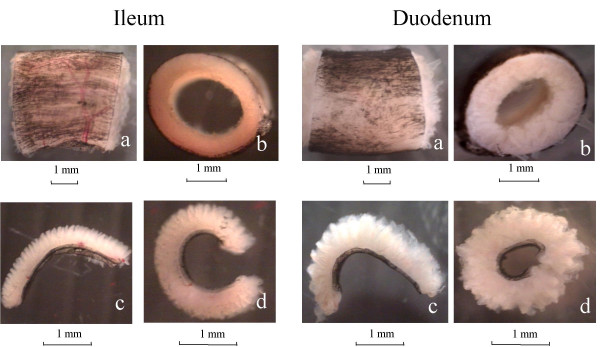
Photograph of specimen from the distal ileum(left) and duodenum (right) in small organ bath containing the Krebs solution. Top: the no-load state of the intestinal segment (about 3–4 mm in length) with longitudinal image (a) and cross-sectional image (b). Bottom: the longitudinal zero-stress state was obtained by cutting the segment (a) into longitudinal strips. The bending angle φ < 180° (c) and >180° (d).